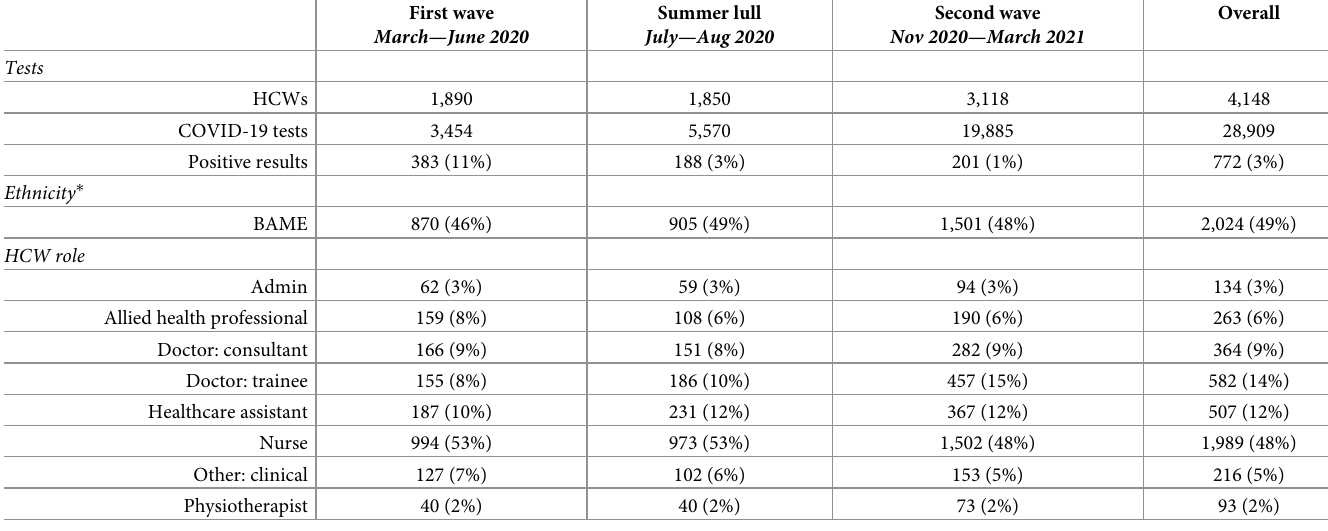
Table 1. Summary for the healthcare worker population studied during the first year of the COVID-19 pandemic. A count for the number of healthcare workers and COVID-19 test results are reported. The number and percentage of positive test results are reported. A count and percentage representation (of the observed population) by ethnicity and healthcare worker (HCW) role is also provided.